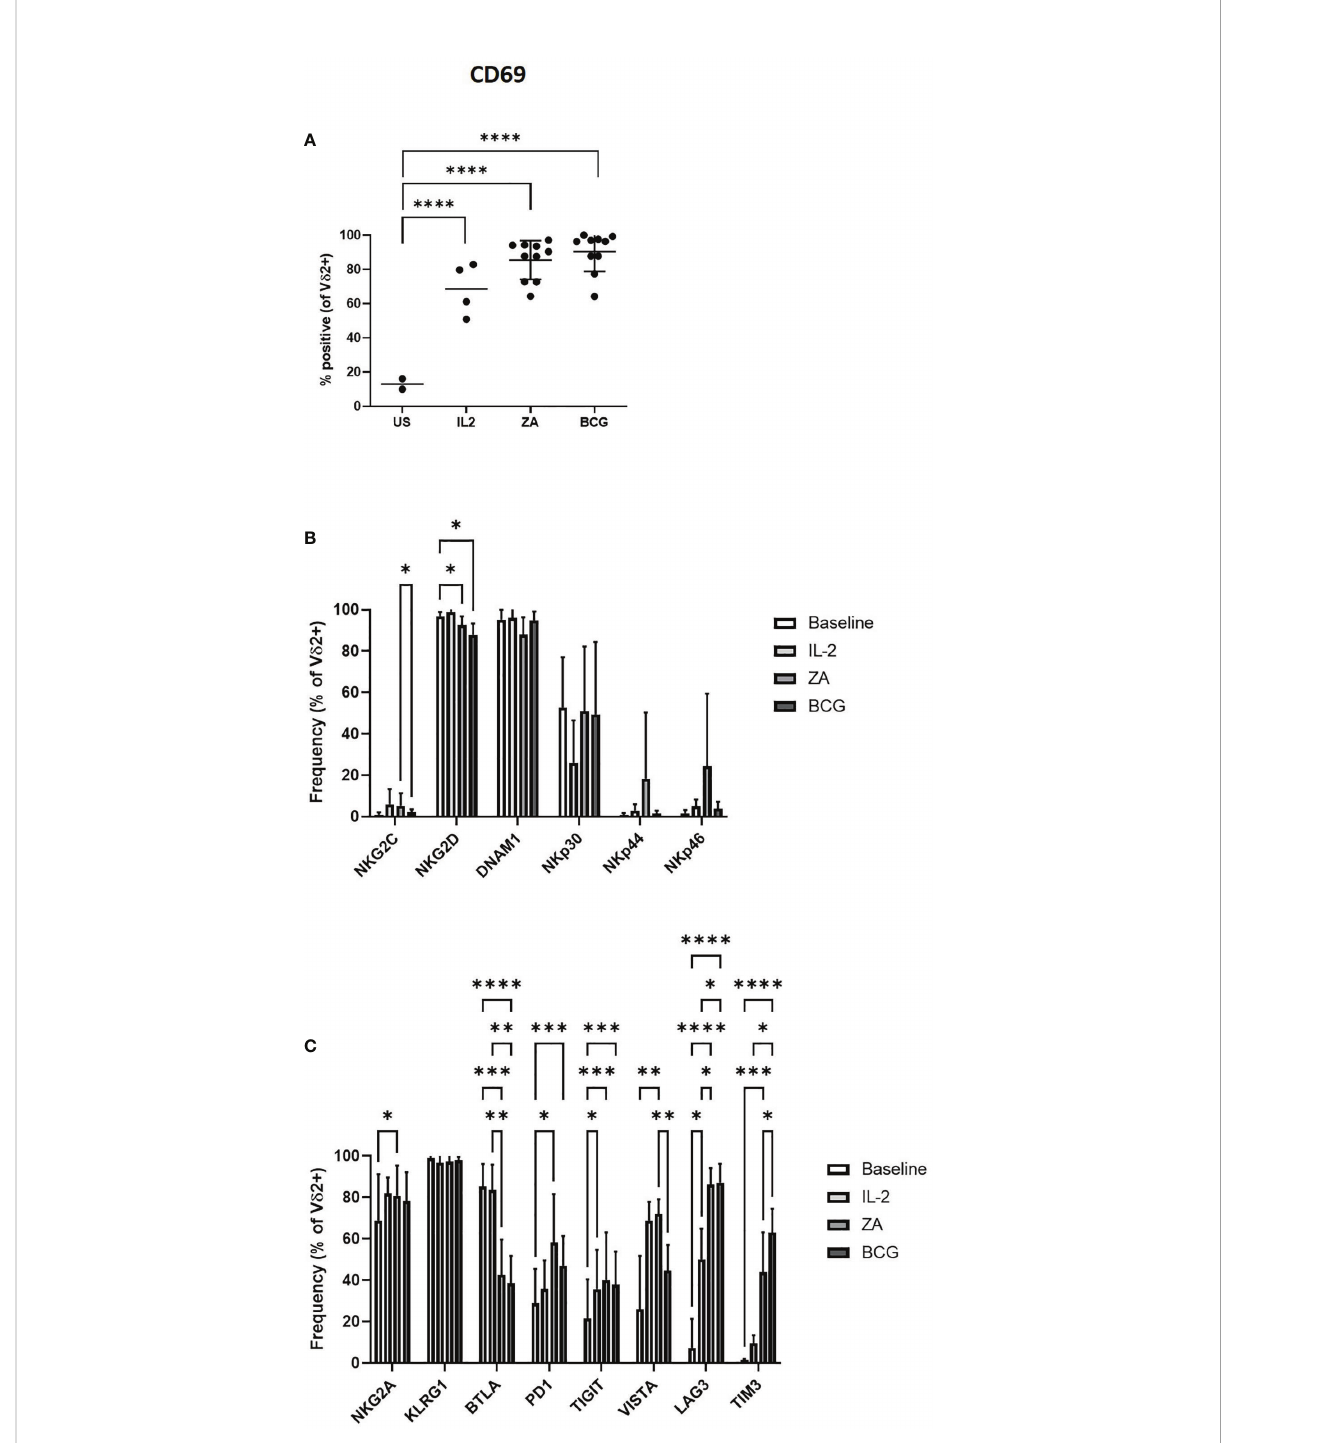
FIGURE 2 Activation of V d 2 cells was assessed by fl ow cytometry of CD69 expression following 24 hours stimulation with IL-2, ZA or BCG both with IL-2 (A) . Expression of NK associated activatory markers (B) and inhibitory checkpoint receptors (C) was determined on V g 9V d 2 T-cells in PBMC stimulated for 24 hours with IL-2 alone, ZA or BCG, both with IL-2, using fl ow cytometry. N=10. *p<0.05, **p<0.005, ***p<0.0005, ****p<0.0001, non-parametric mixed effects analysis with Tukey ’ s post hoc for multiple pairwise